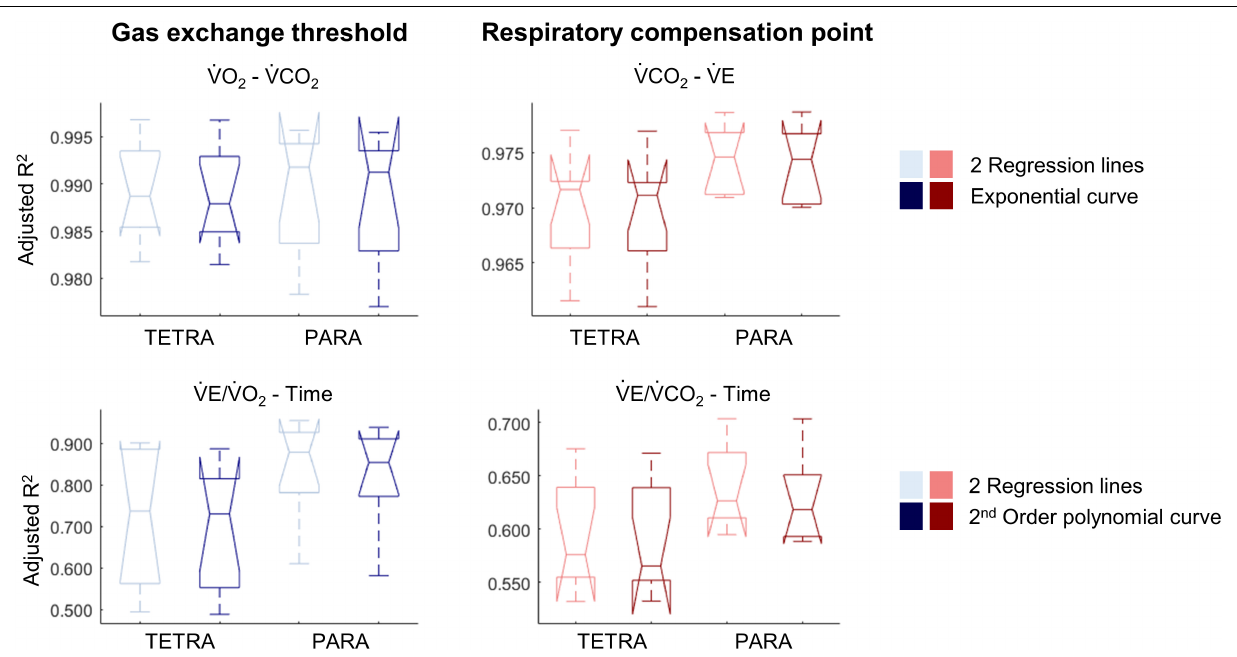
FIGURE 5 | Notched boxplots to compare the adjusted R 2 values of the breakpoint model (i.e., two linear regression lines) vs. the non-breakpoint model (i.e., exponential curve/second-order polynomial) to the respiratory data of 9 wheelchair athletes with a tetraplegia (TETRA) and 8 wheelchair athletes with a paraplegia (PARA). ˙VO 2 , Oxygen uptake; ˙VCO 2 , carbon dioxide production; ˙VE, minute ventilation). Note that the notches extending beyond the 25 th or 75 th percentile indicate that the 95% CI interval ranges exceed the